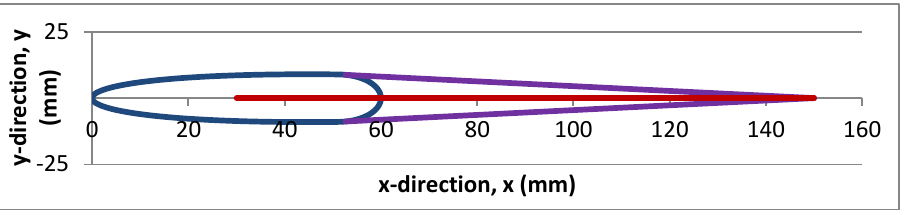
Figure 6. Airfoil cross section at δ =